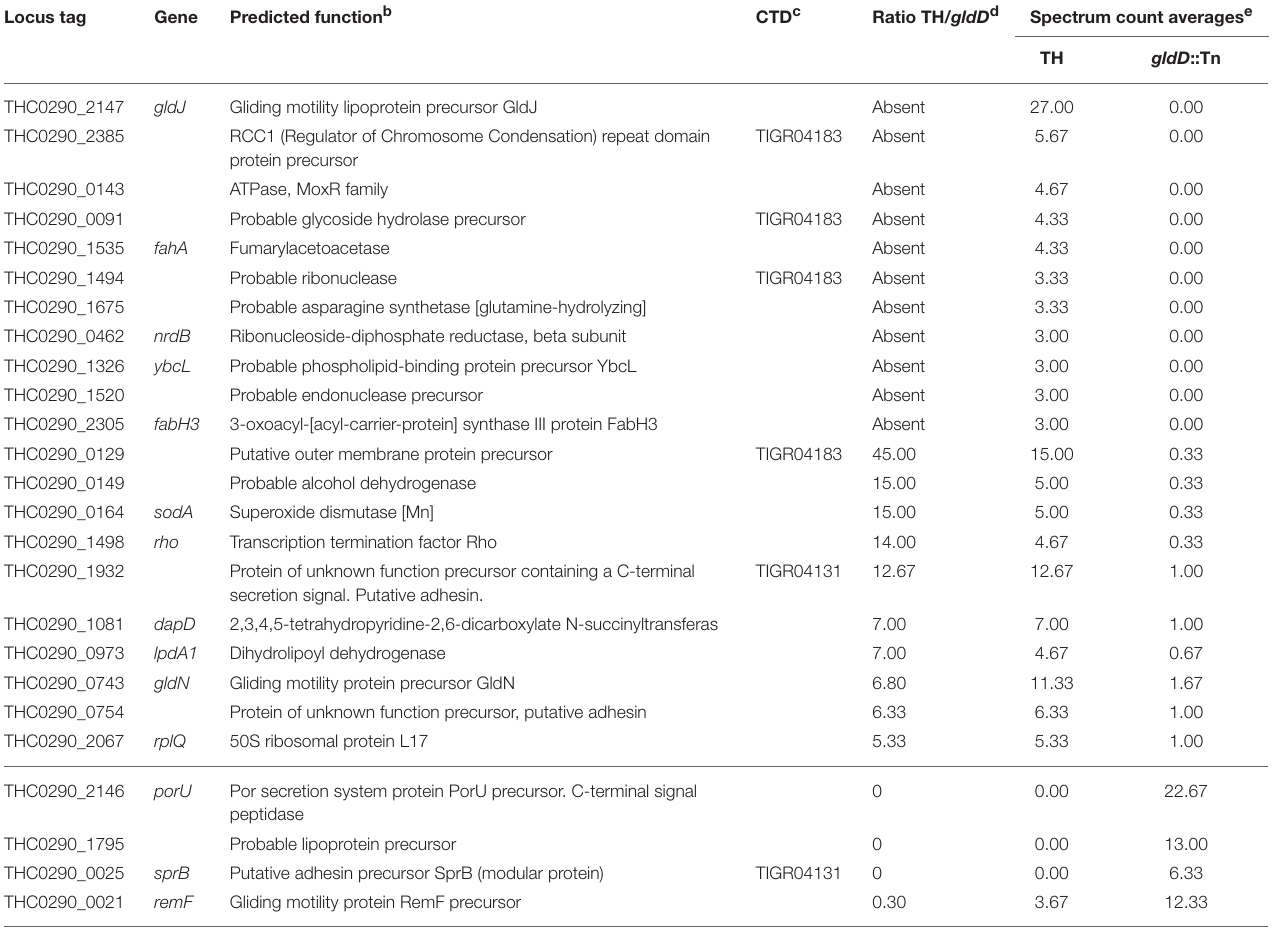
TABLE 4 | Surfome of strains THCO2-90 and gldD::Tn identified by LC-MS/MS analysis a . Locus tag Gene Predicted function b CTD c Ratio TH/ gldD d Spectrum count averages